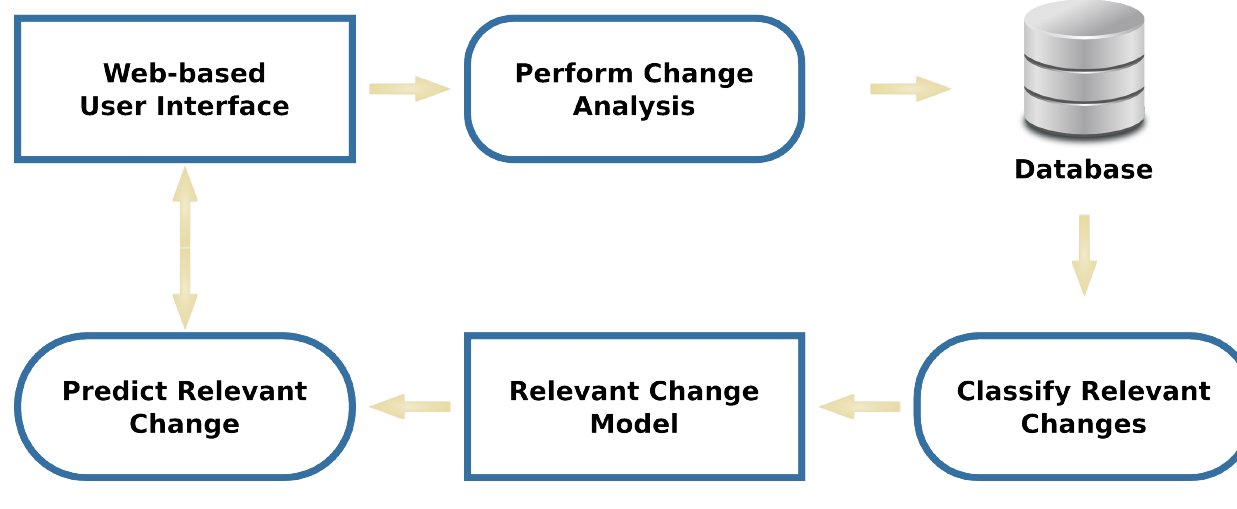
Figure 4. Overall workflow for using binary classification to predict relevant